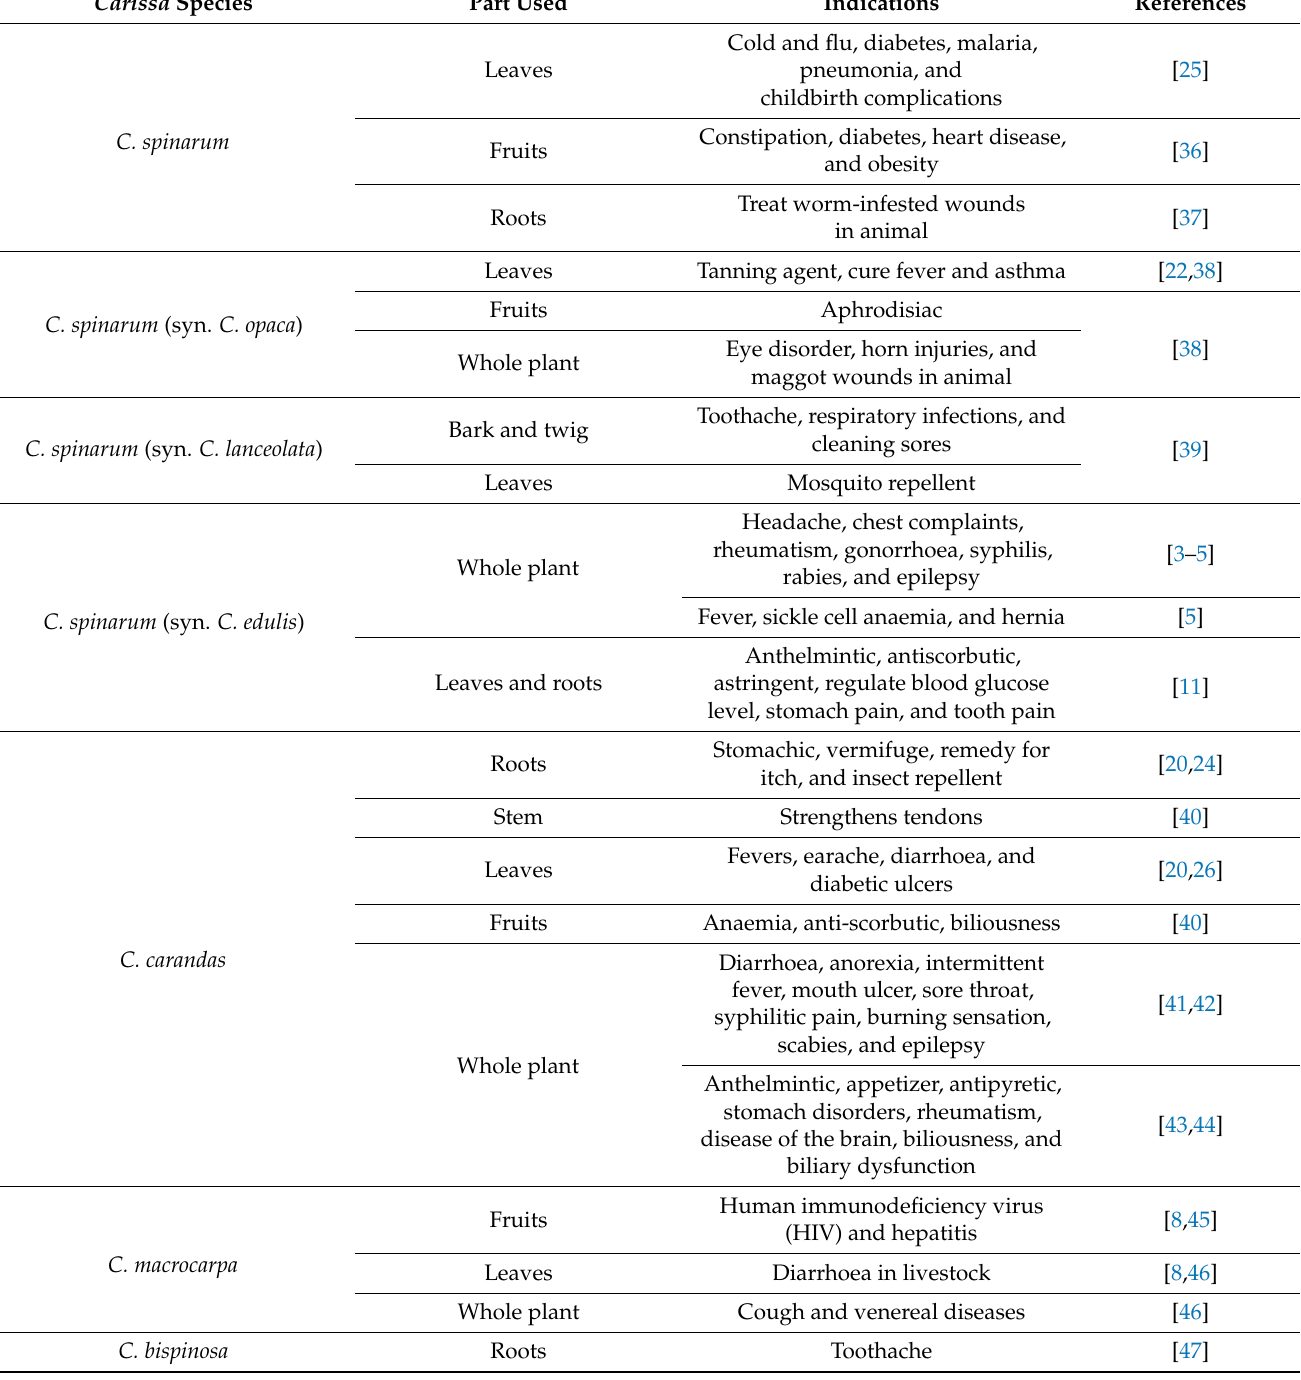
Table 1. Ethnomedicinal uses of Carissa